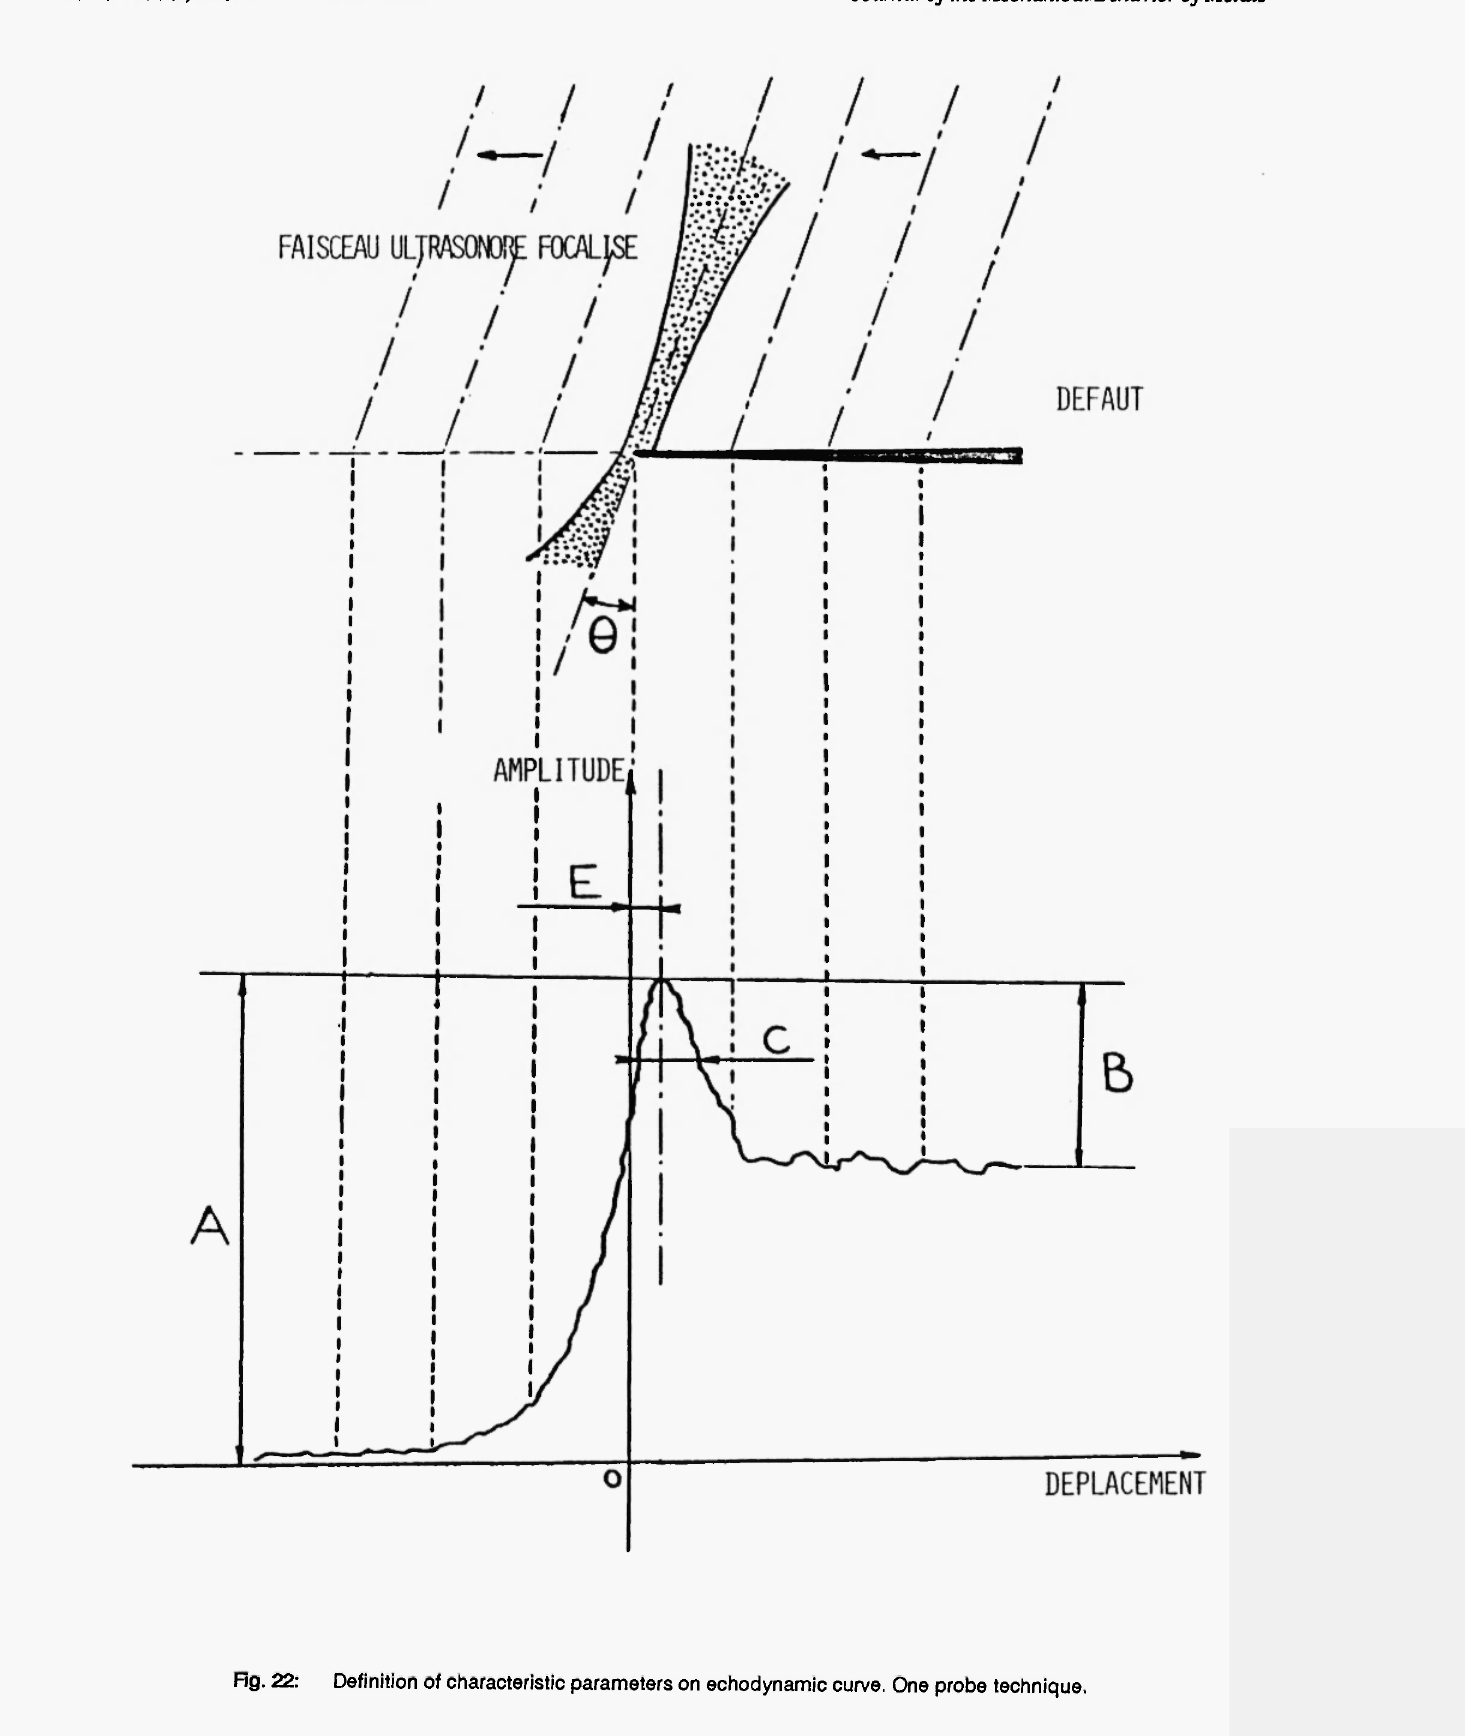
Fig. 22: Definition of characteristic parameters on echodynamic curve. One probe